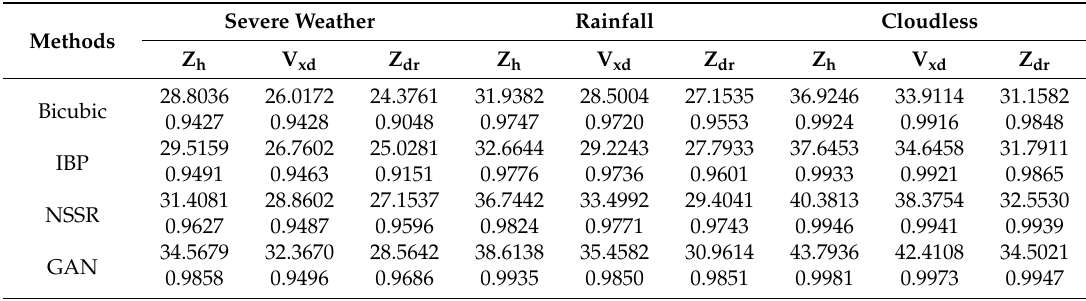
Table 3. Average PSNR (dB) and SSIM results of the reconstructed echo of five groups of level-II data products of XPRAD radar ( × 4).